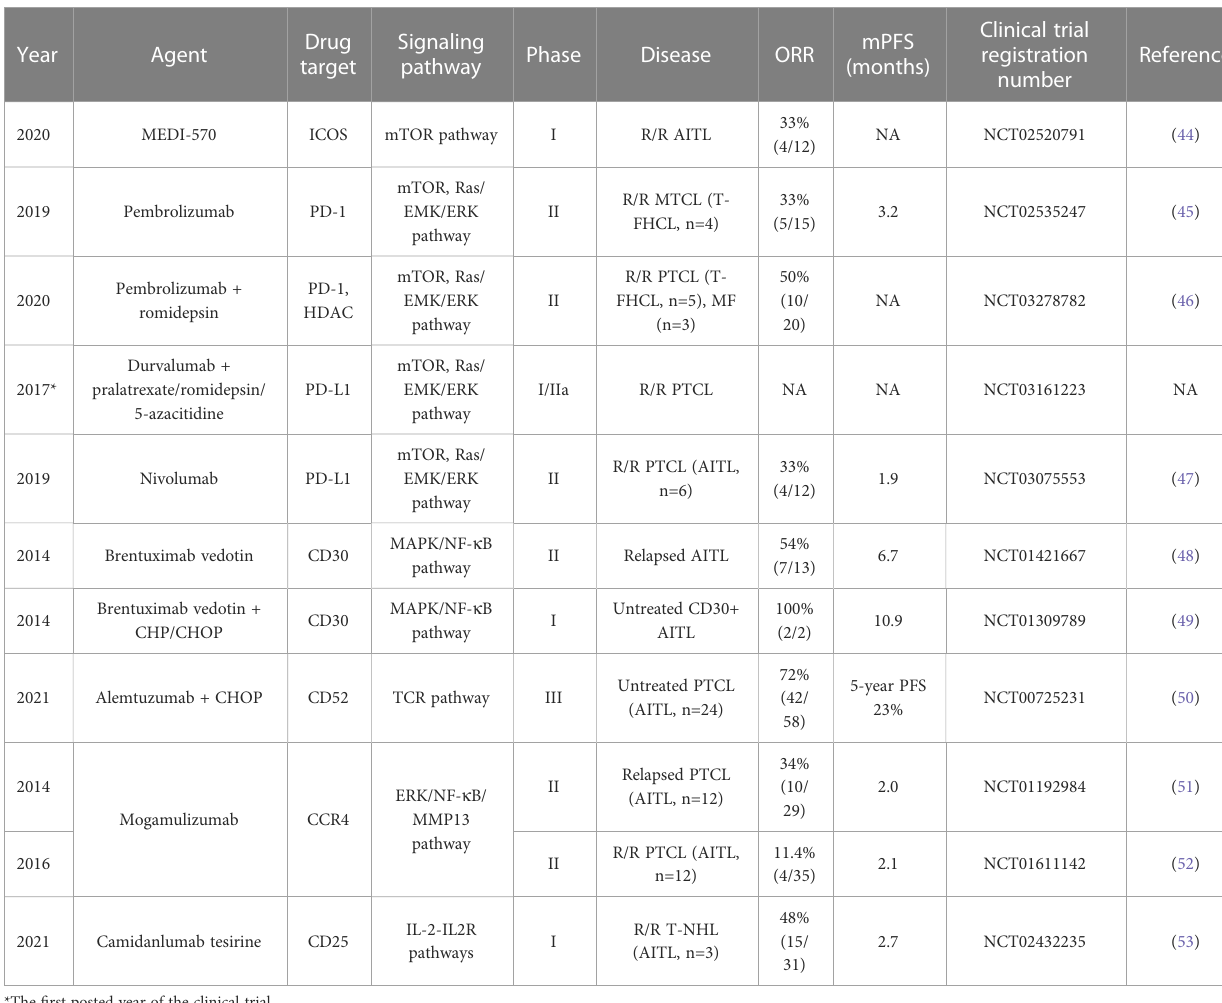
TABLE 2 Novel and experimental agents targeting surface molecules in